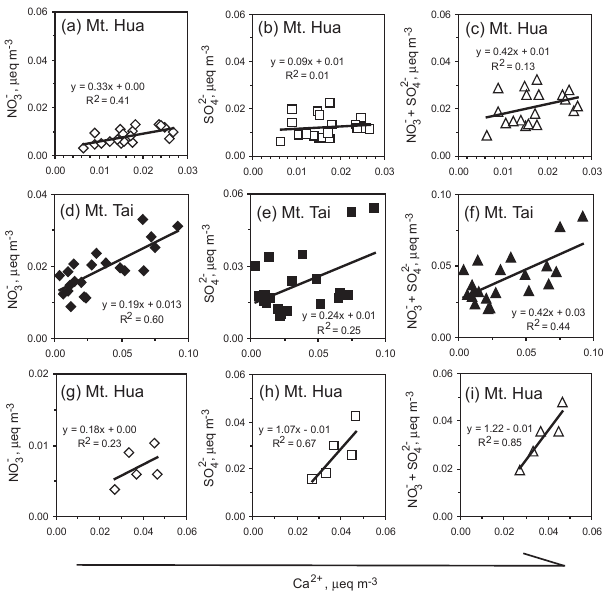
Fig. 12. Equivalent ratios of calcium to nitrate, sulfate and the sum Fig.12 Equivalent ratio of calcium to nitrate, sulfate and the sum of nitrate and sulfate in particles with a diameter > 2.1 µ m during (a-f) the non-dust storm and (g-i)dust storm periods of nitrate and sulfate in particles with a diameter larger than 2.1µm